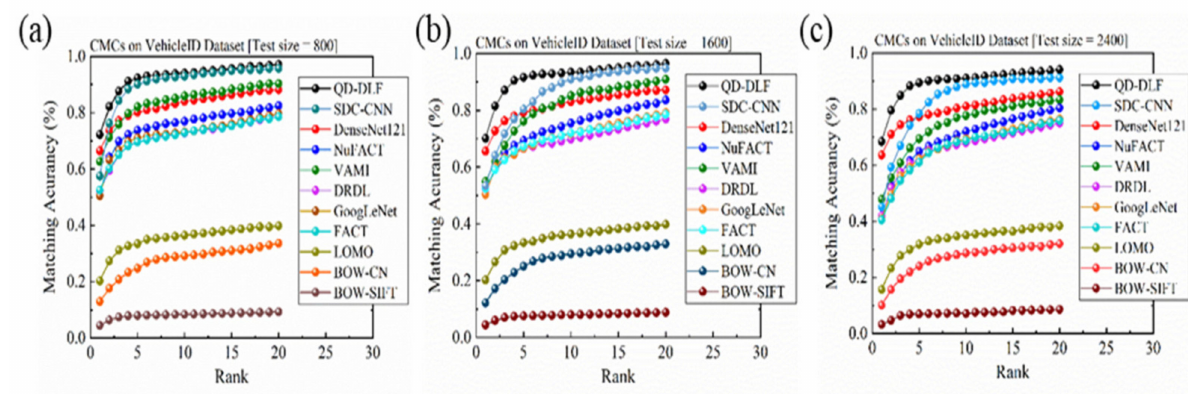
Figure 31. Demonstrates the performance comparison of different state-of-the-art approaches on VehicleID dataset. ( a ) Test size = 800; ( b ) Test size = 1600; ( c ) Test size =